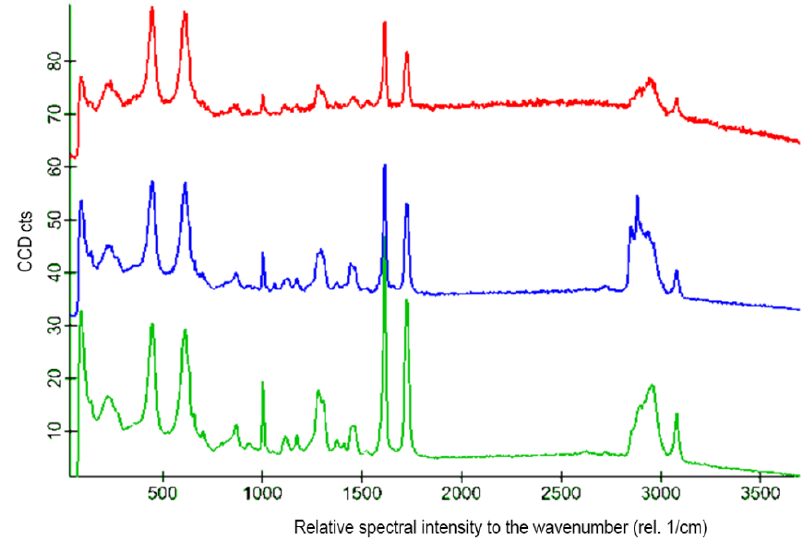
Figure 6. Average spectra corresponding to the colored areas in the sample with failure caused by persistent salmon muscle adhesion.